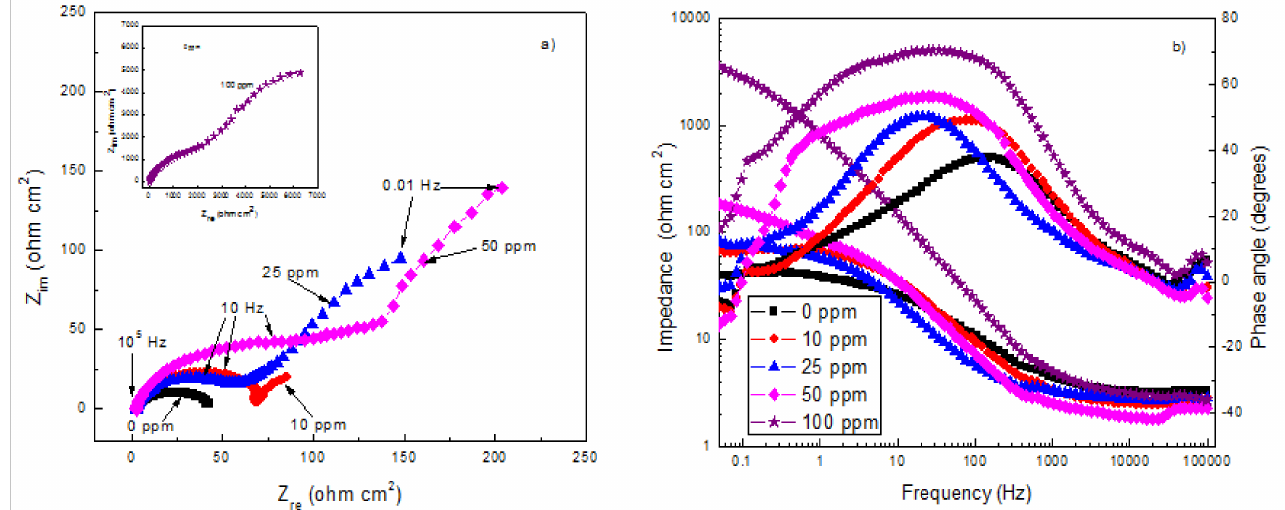
Figure 7. ( a ) Nyquist and ( b ) Bode diagrams for X-120 steel in a CO 2 -saturated NaCl solution at 50 ◦ C containing different concentrations of gemini surfactant.